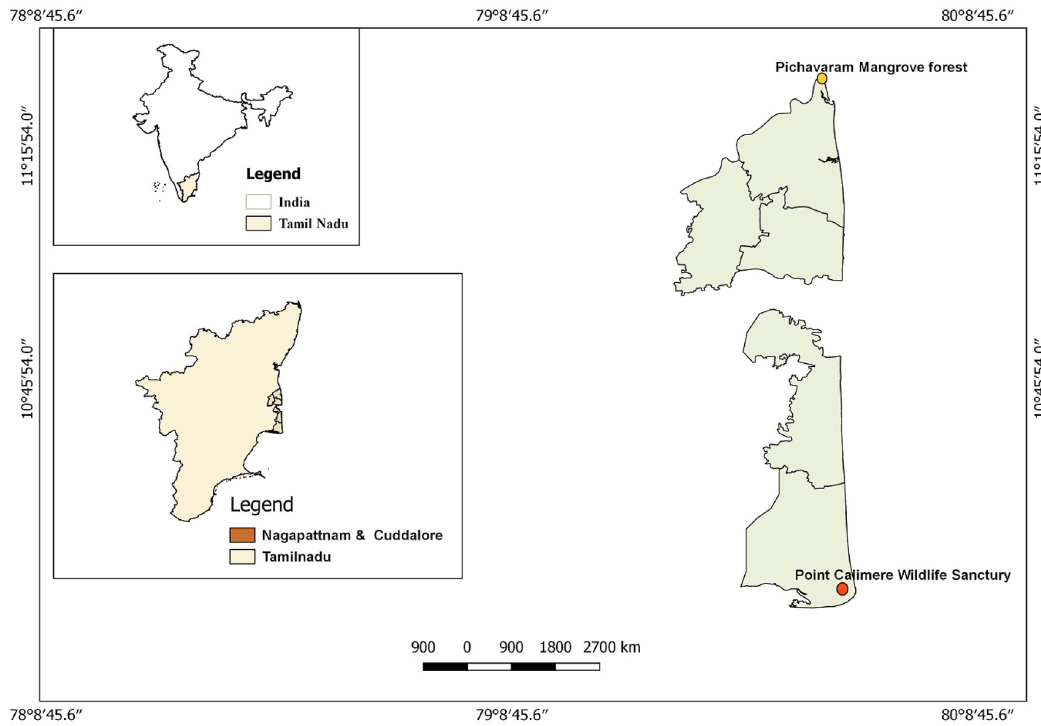
Figure 1. Map showing the Point Calimere Wildlife Sanctuary, Kodikkarai, Pichavaram Mangrove Forest, Cuddalore District, Tamil Nadu, India. The map is generated by using ArcGIS 10.0; ENVI + IDL License No.239509; The software is purchased by the Department of Zoology and Wildlife Biology, AVC College (Autonomous),Mannampandal, Mayiladuthurai, Tamil Nadu, India; The ArcGIS webpage: https ://www.arcgi s.com/index